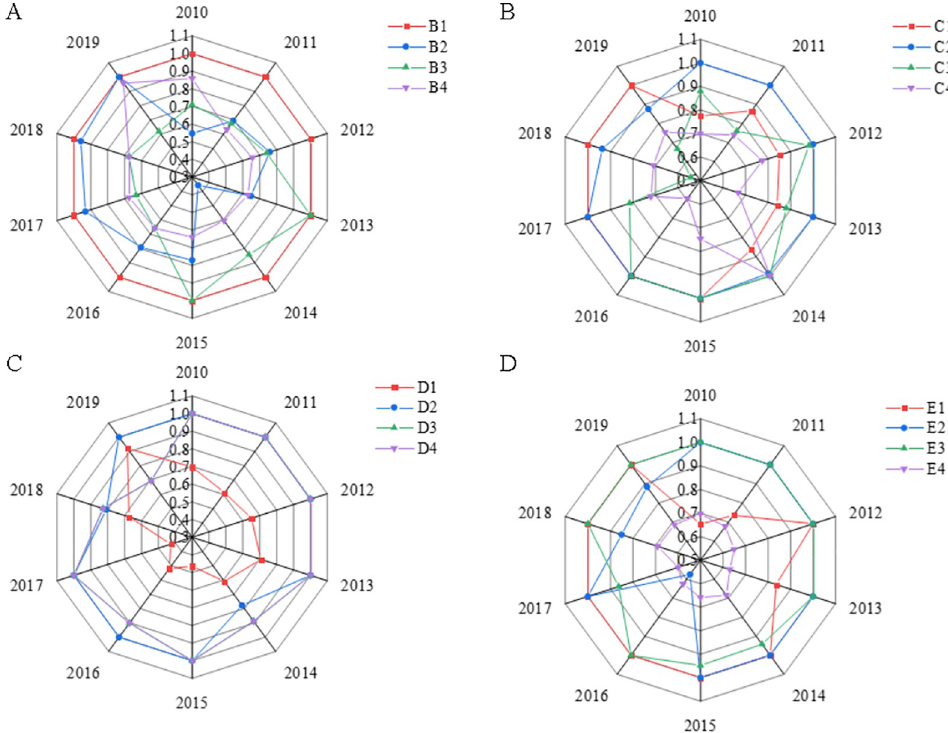
Fig 7. Economic efficiency results of high-tech IDZs in different provinces and different